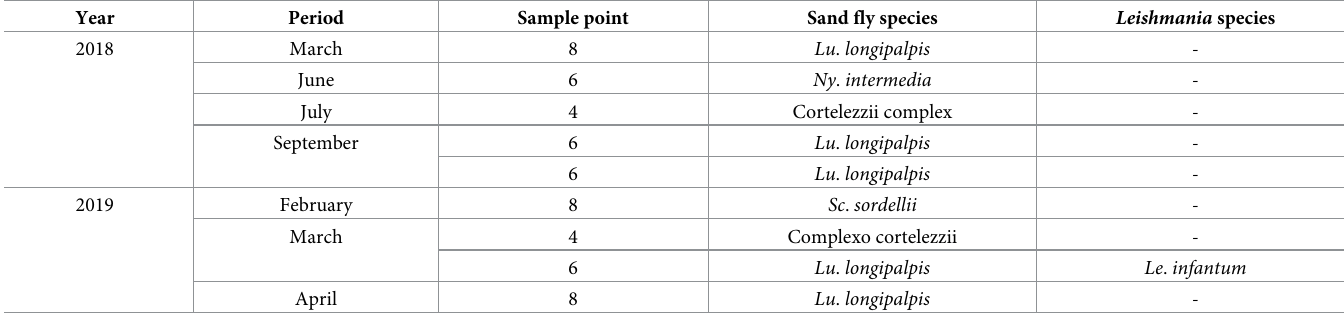
Table 3. PCR IST1 molecular analysis positive samples and Leishmania species identification in sand flies collected in Lassance, Minas Gerais, Brazil.